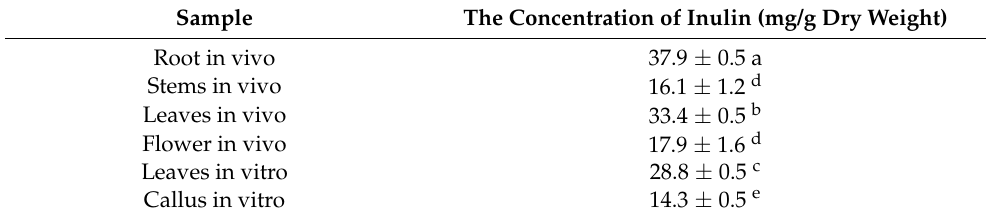
Table 3. Concentration of inulin of Cichorium intybus L. using a spectrophotometer ([4]). Sample